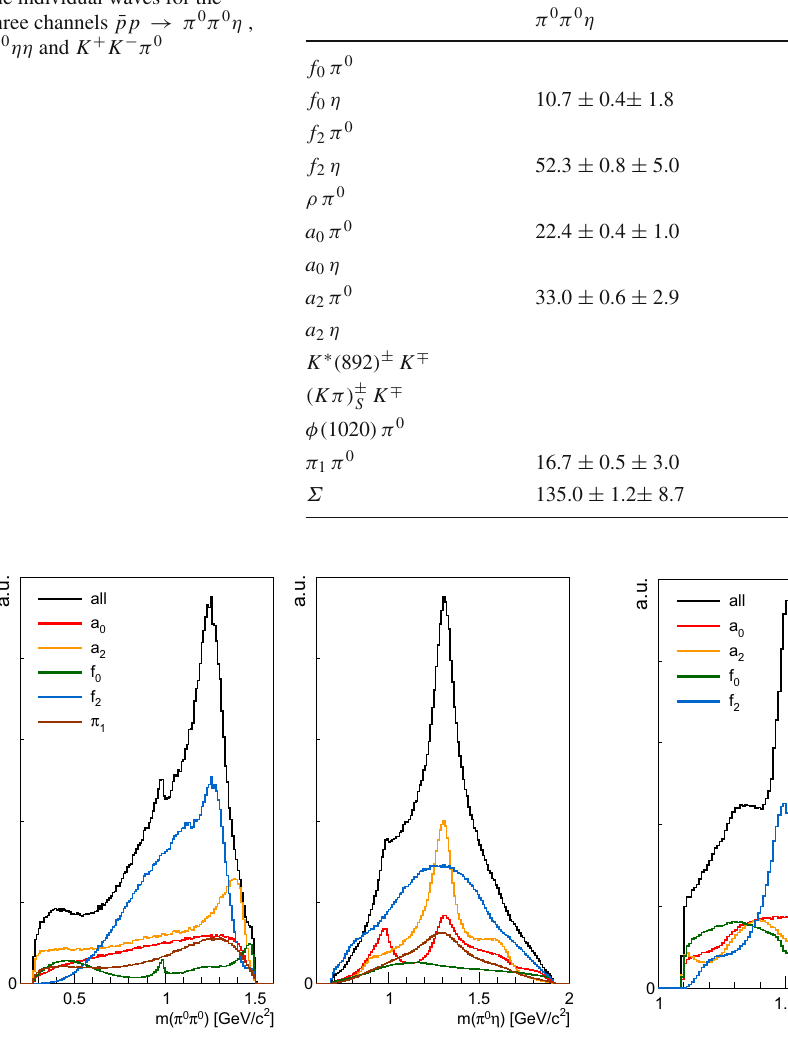
Table 3 Contributions in % of the individual waves for the